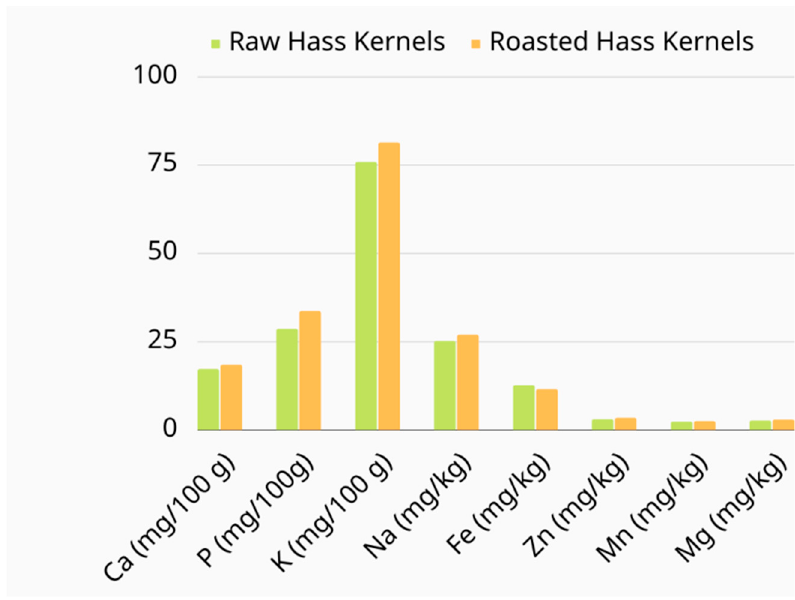
Figure 1. Mineral content in raw and roasted Hass kernels (dry weight basis).